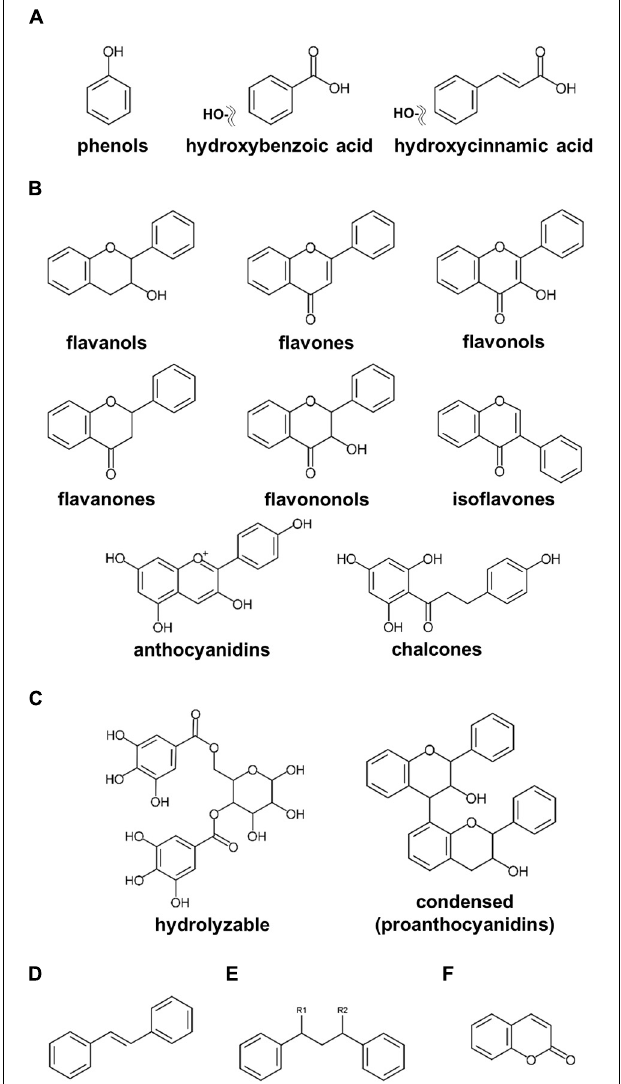
FIGURE 1 | Core structures of polyphenolics found in major nut plant species. (A) phenols and phenolic acids. (B) flavonoids. (C) tannins. (D) stilbenoids. (E) lignans. (F)